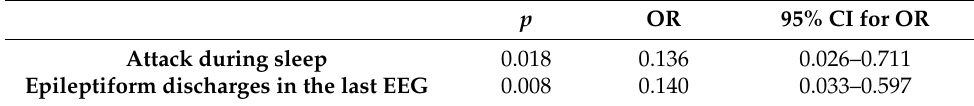
Table 3. Factors independently associated with ongoing seizures in the patients with